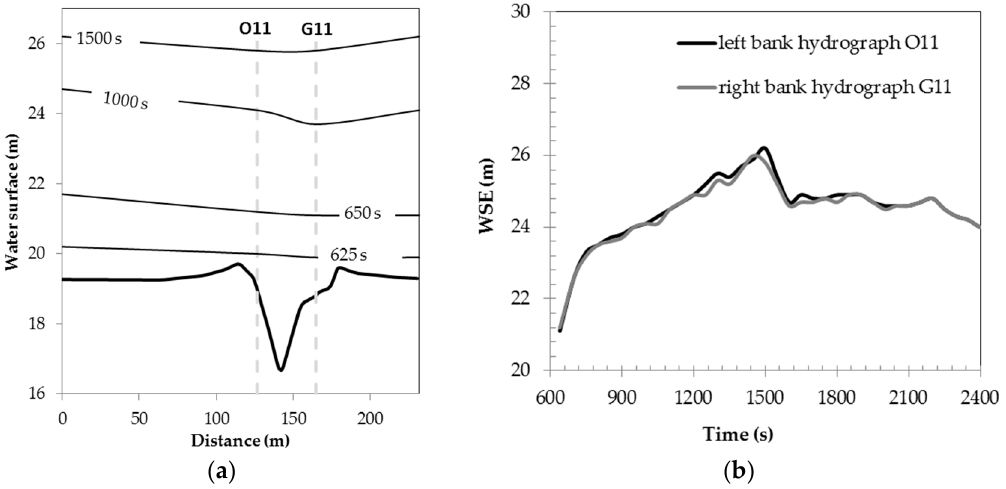
Figure 12. Water surface elevation at the cross section G11 ‐ O11: ( a ) free surface along the section at different times after the dam break ( T = 625 s, 650 s, 1000 s and 1500 s); and ( b ) water discharge hydrograph in the right (grey line) and left (black line) banks predicted by the 3D model.